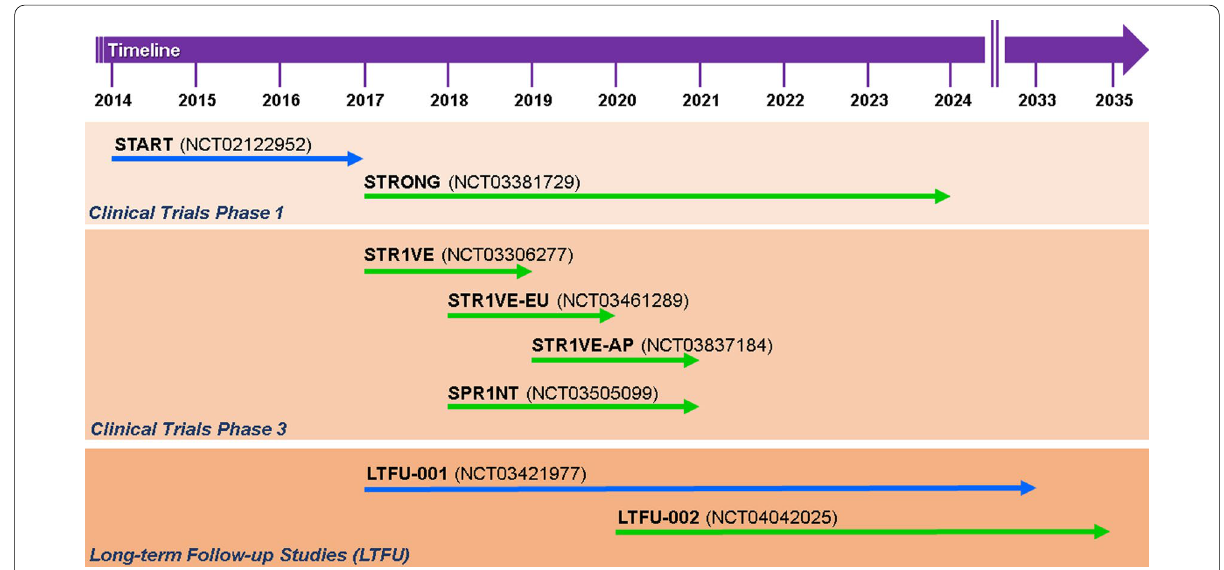
Fig. 3 Timeline of the current Onasemnogene abeparvovec/Zolgensma ™ trials. Illustration of the different clinical trials (clinical trials 1 and 3, LFTU) with Onasemnogene abeparvovec/Zolgensma ™ according to their scheduled